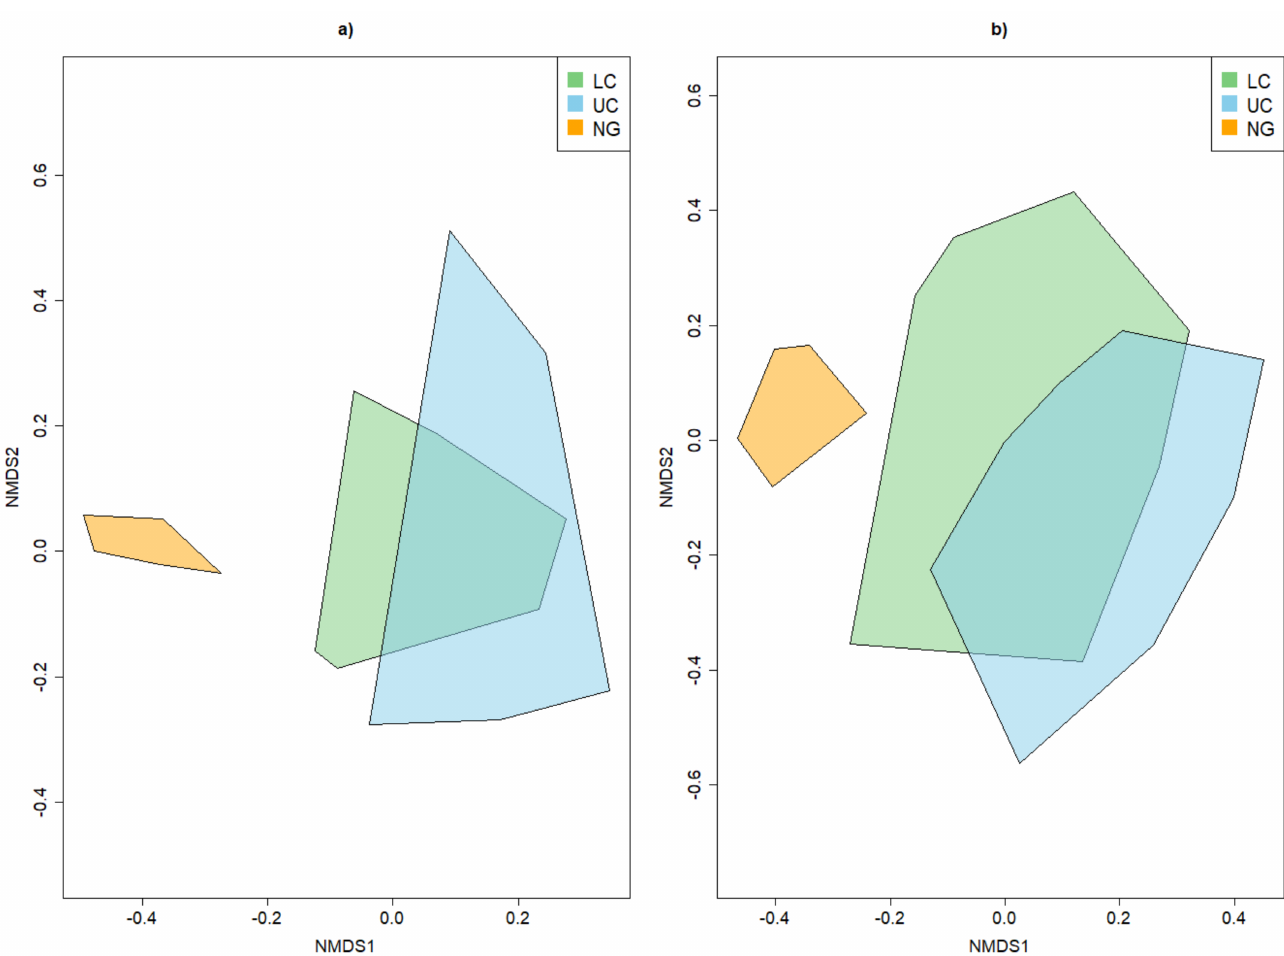
Figure A13. NMDS plot demonstrating the influence of strata on the overall beta diversity for the common beetle species ( a ) and the rare beetle species ( b ), rarity classification according to the octaves. NG—near-ground stratum, LC—lower canopy, UC—upper